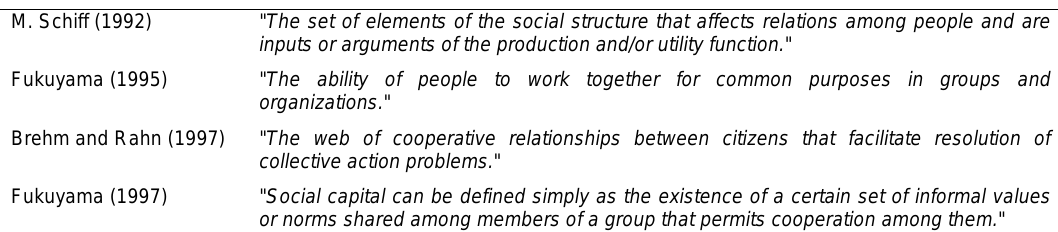
Table 2 . Definitions of social capital in the communitarian perspective. Authors Communitarian